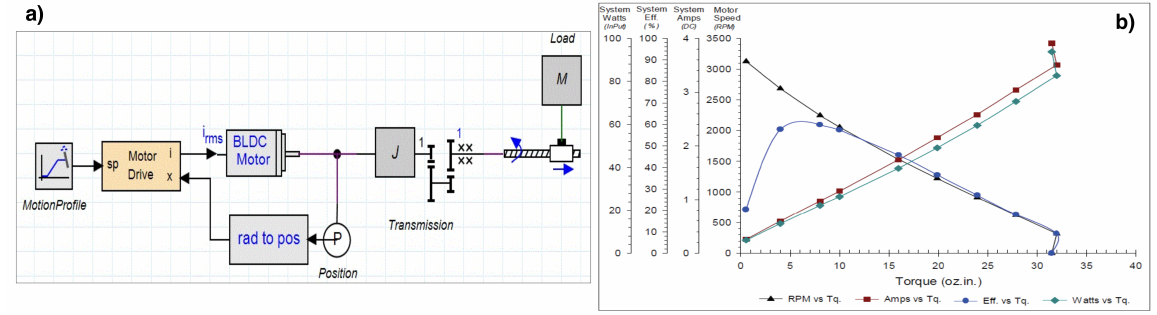
Figure 1. Single-axis mechanical model for the case study in ( a ), with the brushless DC motor characteristics in ( b ), used for system identification and